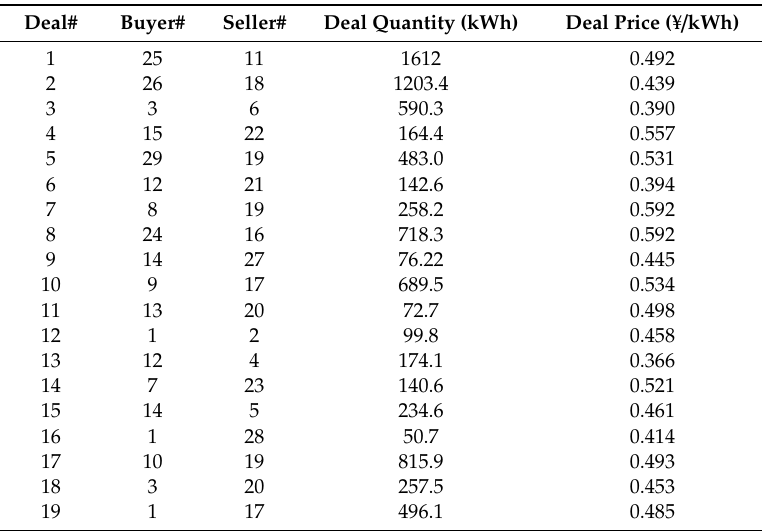
Table 1. Deals of P2P electricity transaction in 8th hour ( t = 8).